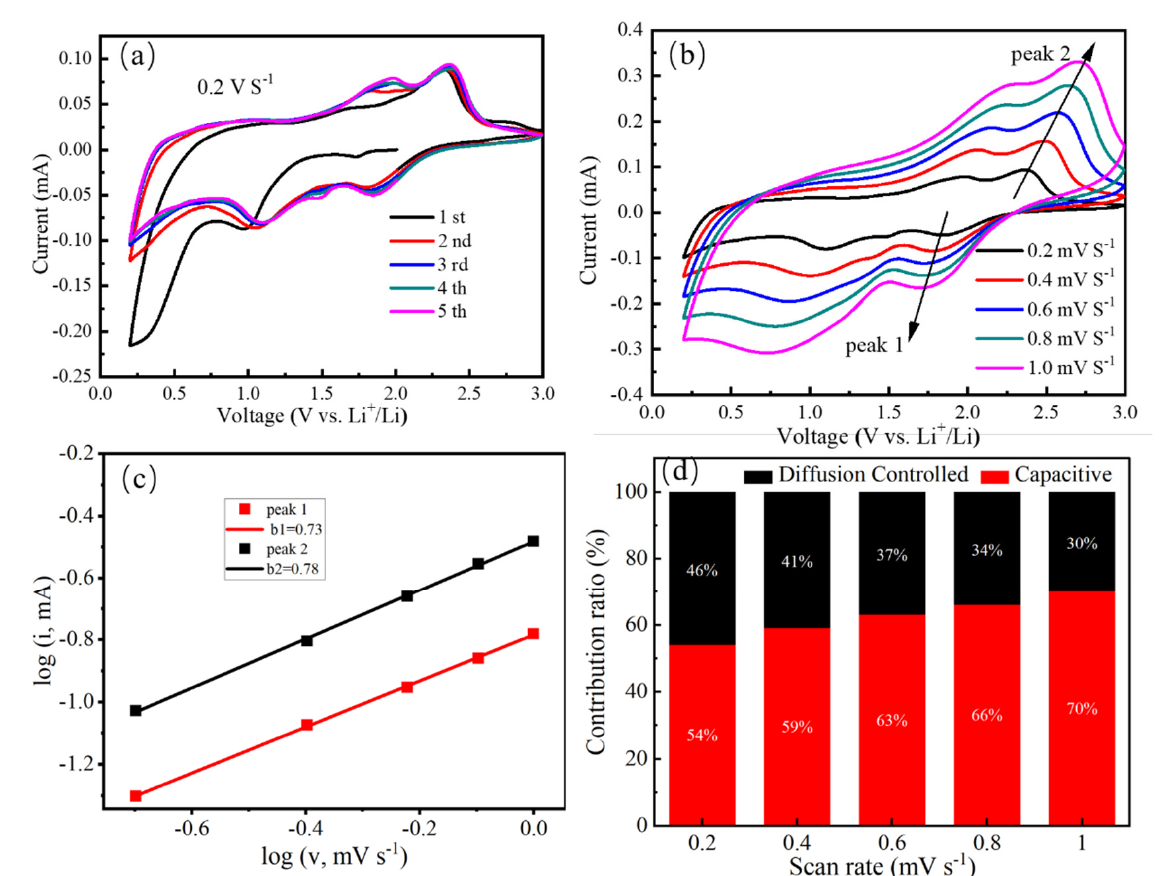
Figure 6. ( a ) CV curves of 1T − MoS 2 − 600 at a sweep rate of 0.5 mV s − 1 , ( b ) CV curves of 1T − MoS 2 − 600 at different sweep rates, ( c ) b values from the oxidation and reduction peaks, and ( d ) the pseudocapacitive contribution of 1T − MoS 2 −